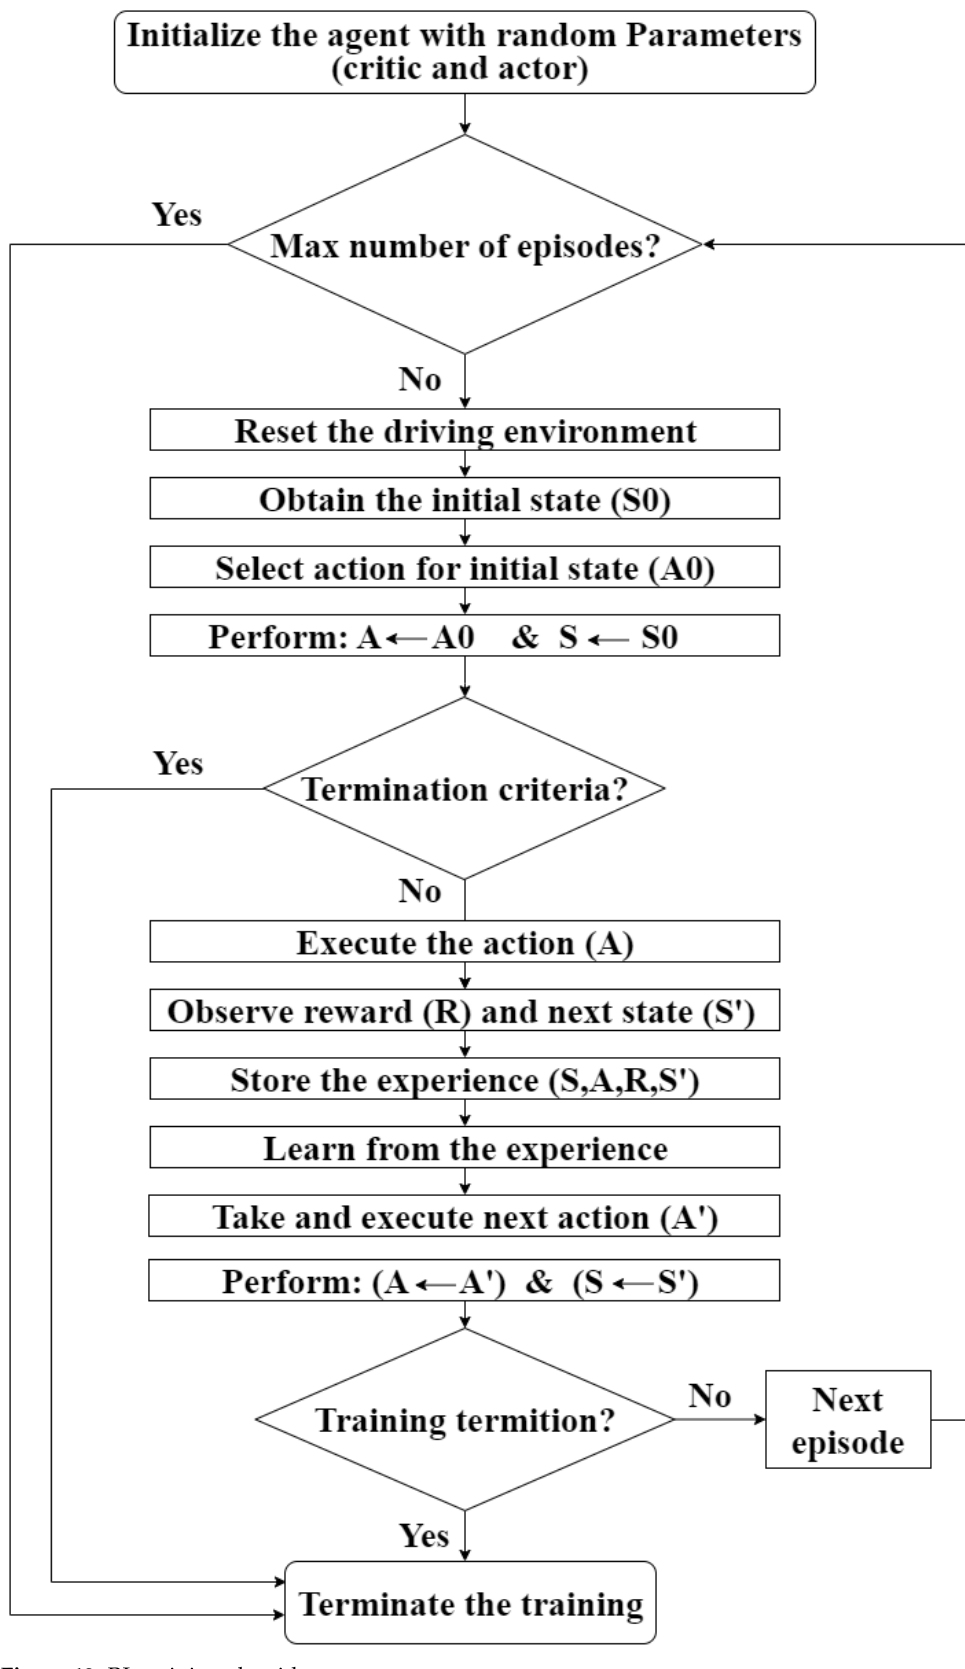
Figure 12. RL training